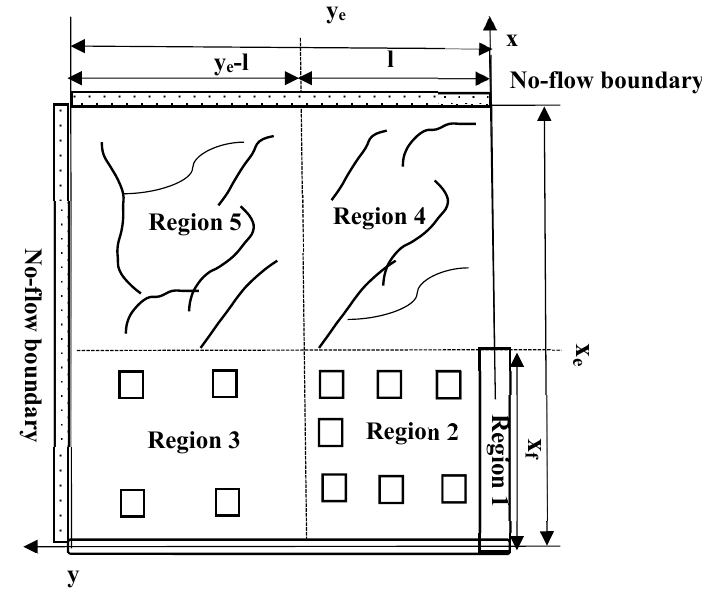
Figure 2. Schematic of the five-region flow model for a multi-fractured horizontal well.